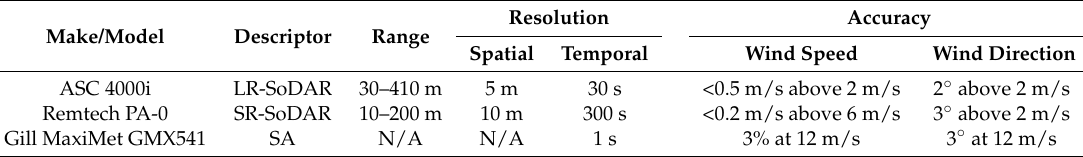
Table 2. Accuracy specifications for sonic anemometer and SoDAR wind